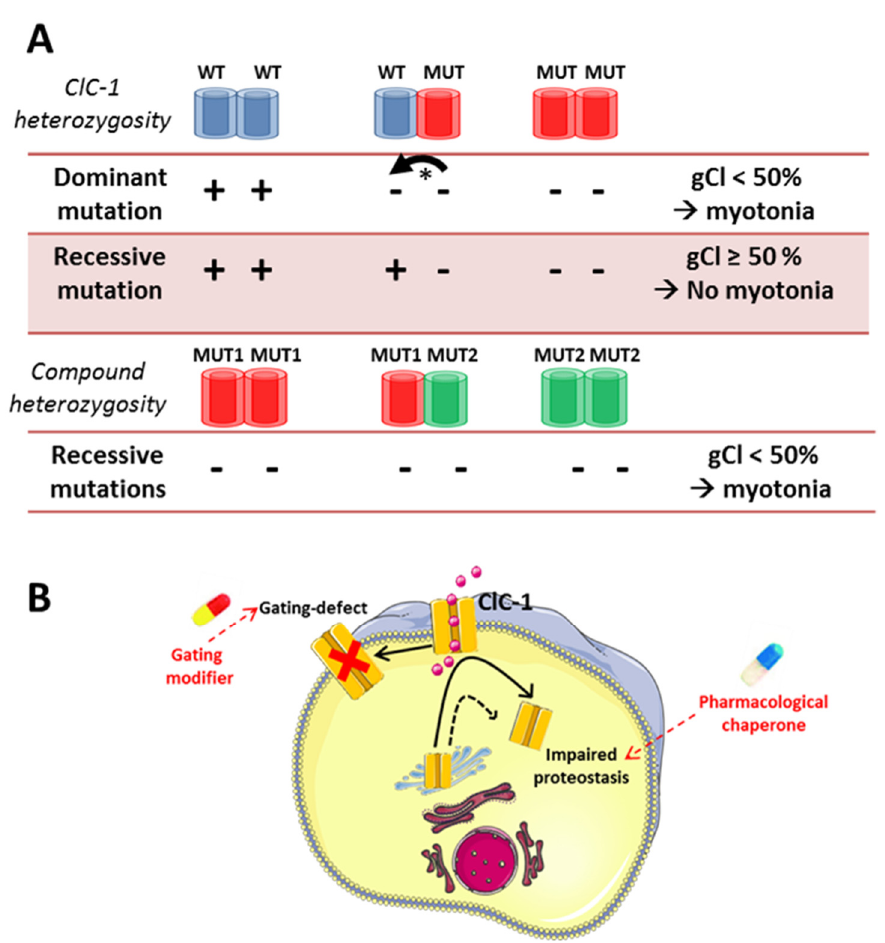
Figure 4. Pathomechanisms of CLCN1-related myotonia congenita (MC). ( A ) Presumed mechanism of inheritance in MC. The ClC-1 channel is a dimeric protein with a double barrel-like structure: two subunits assemble to form two parallel ion-conducting pores. In the case of heterozygosity, wild-type (WT) and mutated (MUT) ClC-1 subunits can assemble as homodimers, WT–WT and MUT–MUT, and heterodimers (WT–MUT). In autosomal dominant Thomsen’s disease, the mutated subunit is expected to exert a dominant-negative effect (*) on the associated wild-type subunit in the WT–MUT channel. This results in the reduction of sarcolemma chloride conductance (gCl) by more than 50%, leading to muscle fiber hyperexcitability and muscle stiffness. In autosomal recessive Becker’s disease, the recessive mutation is expected to have no effect on the associated WT subunit. The co-expression of the recessive mutation with the wild-type ClC-1 results at maximum in a 50% reduction of the sarcolemmal chloride conductance, which is not enough to cause myotonia. The occurrence of recessive mutations in homozygosity or in compound heterozygosity is required to reduce the sarcolemmal chloride conductance by more than 50% and to induce myotonia. (+: functional ClC-1 subunit, -: impaired ClC-1 subunit). ( B ). The main molecular defects of ClC-1 mutants associated with MC consist of either a defect in ClC-1 proteostasis (protein synthesis, cell trafficking, or proteolysis) or a defect in ClC-1 channel gating. Knowledge of molecular pathomechanism may guide the development of efficient mutant-targeted pharmacological treatments to restore ClC-1 function.